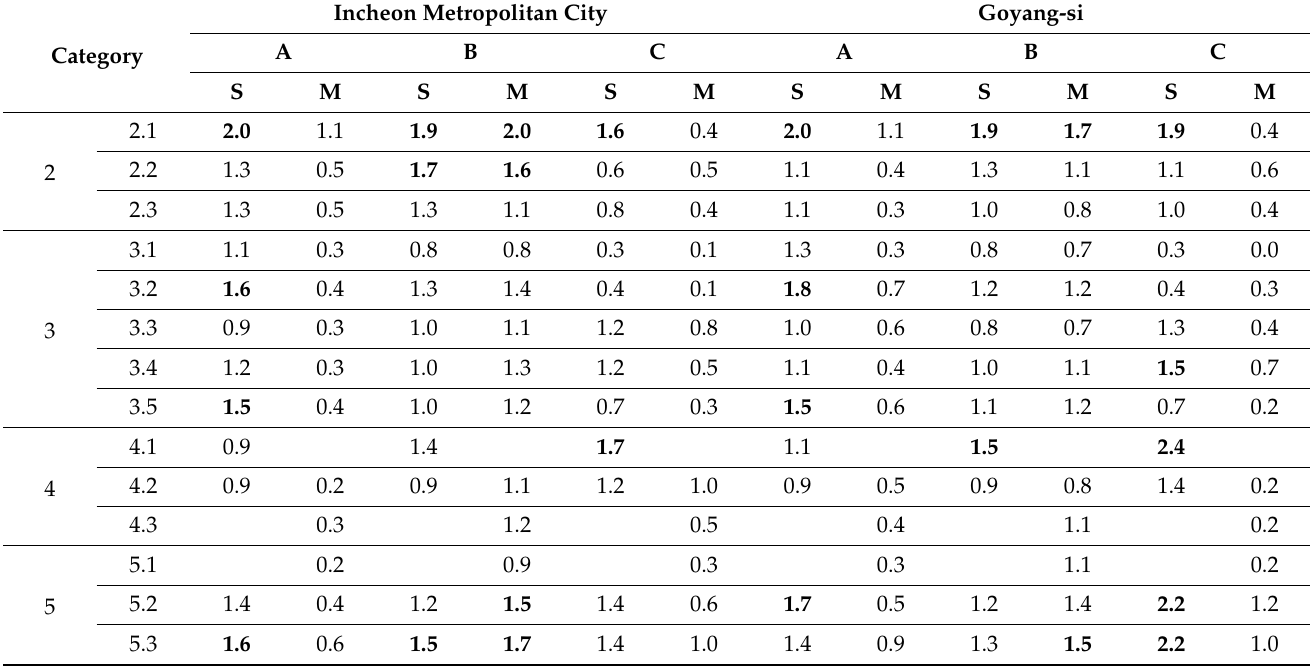
Table 2. Sustainability and smartness score (sub-category) via plan.